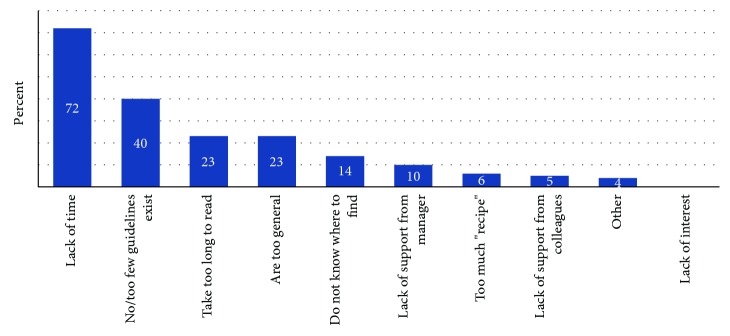
Reported barriers for using guidelines.